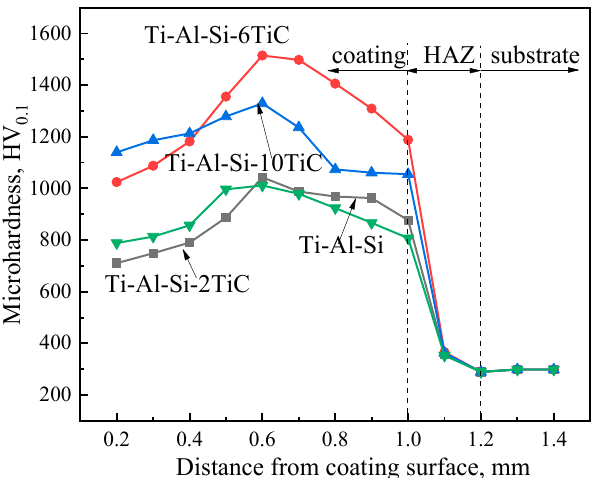
Figure 8. Microhardness curves from the surface of the coating to substrate.